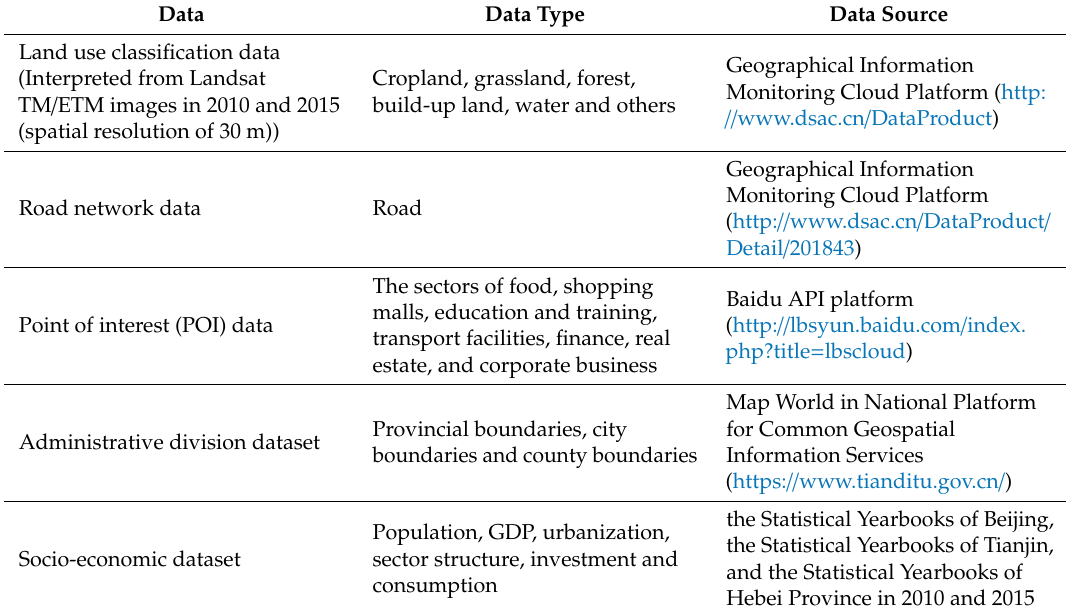
Table 1. Data source